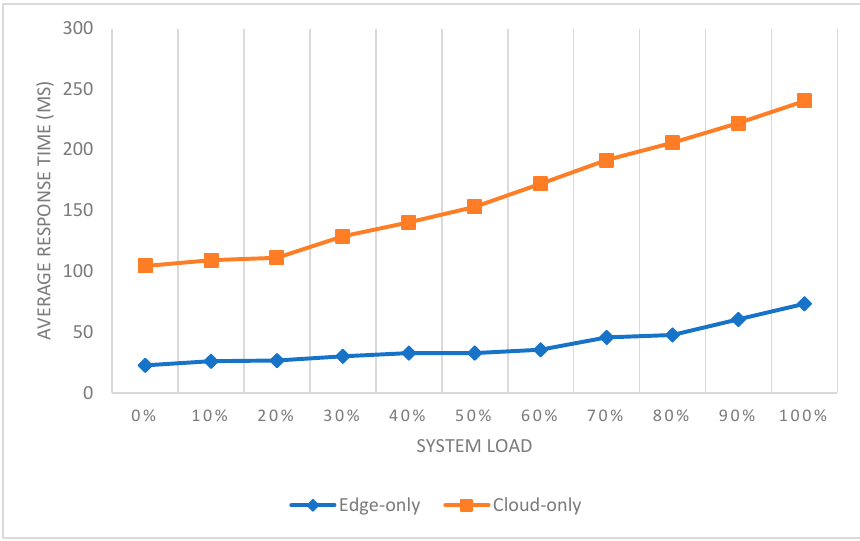
Figure 8. Detection average response time for cloud-only and edge-only scenarios.